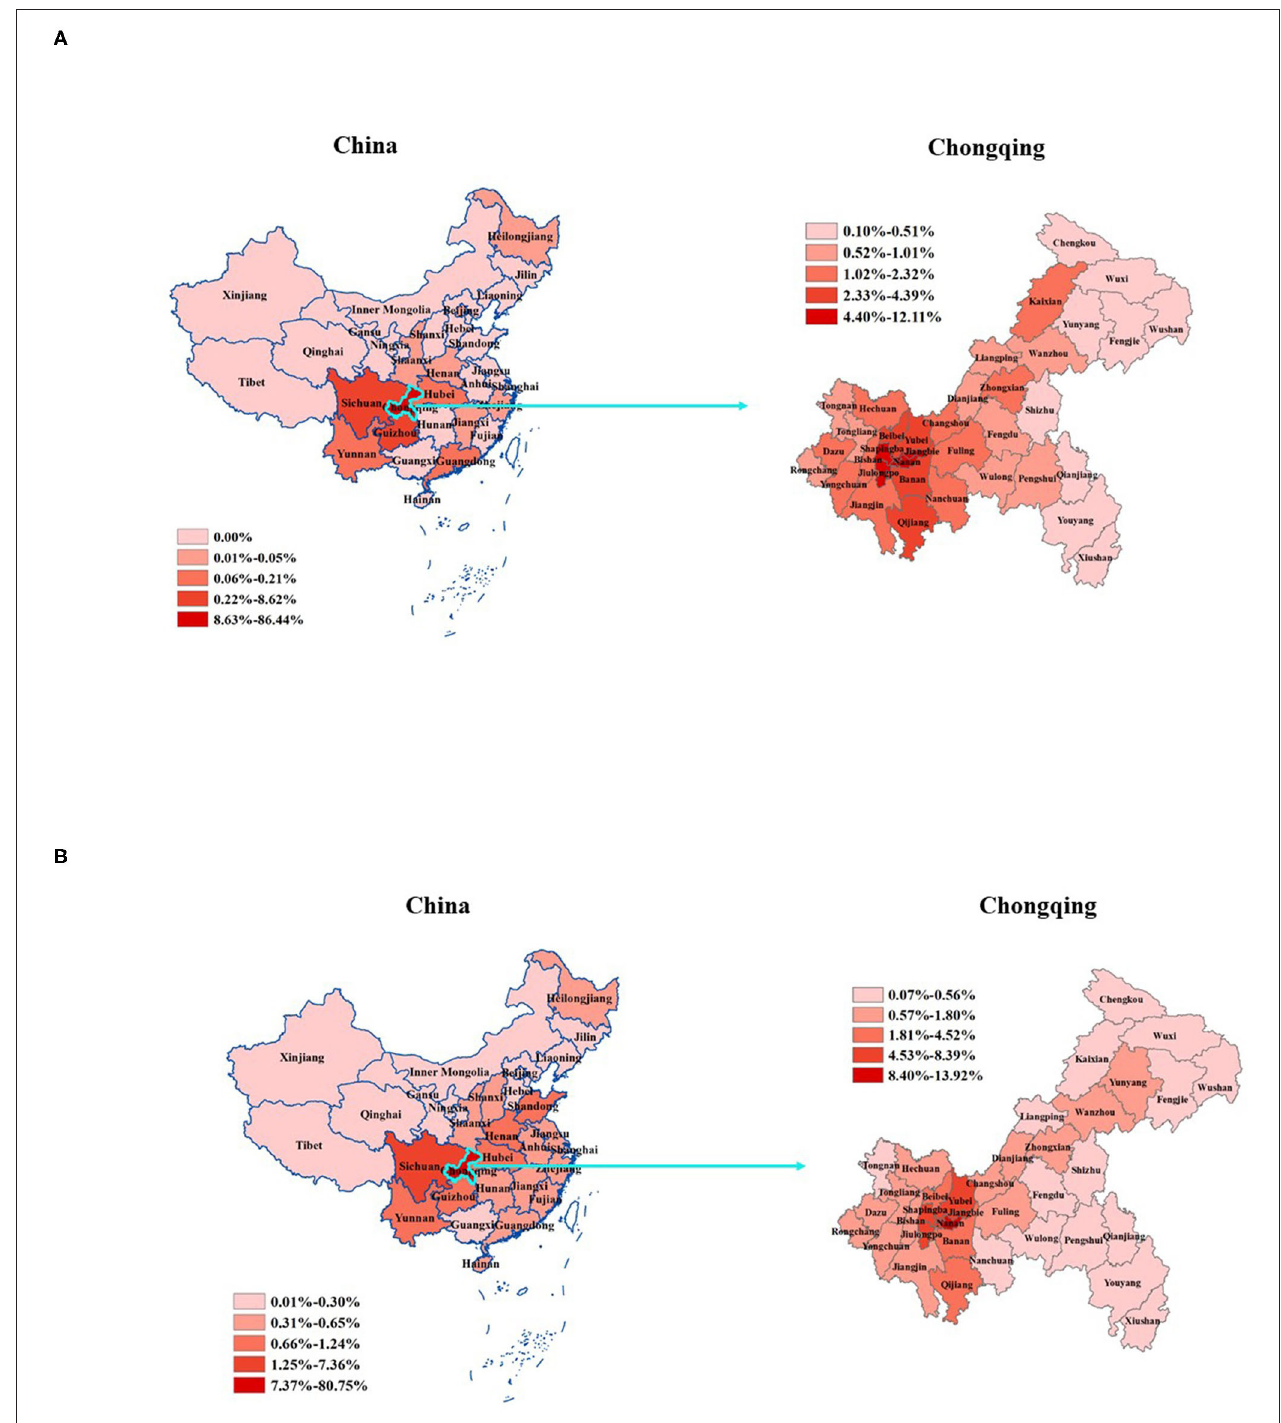
FIGURE 2 | The frequency of corneal donor tissue sources and voluntary donors from different regions of Chongqing and China, 1999–2018. (A) The frequency of preregistered voluntary donors. (B) The frequency of actual donors. We used quintiles to define map strata. The dark red areas represent higher frequencies.